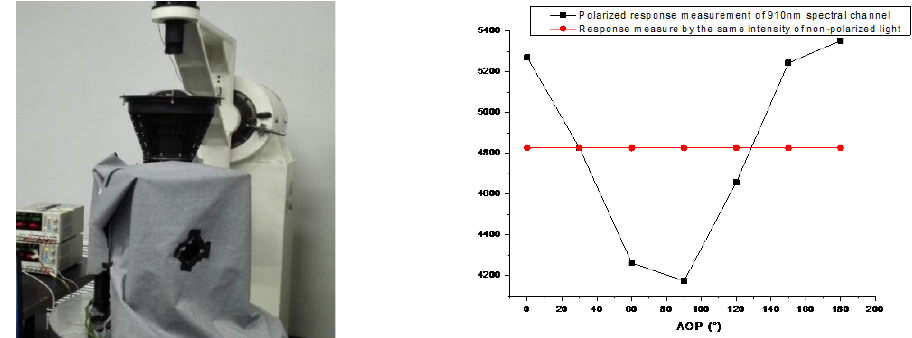
Figure 4. The geometric calibration system for PSOC measurement (left) and PSOC measurement values in 56° FOV of 910nm channel